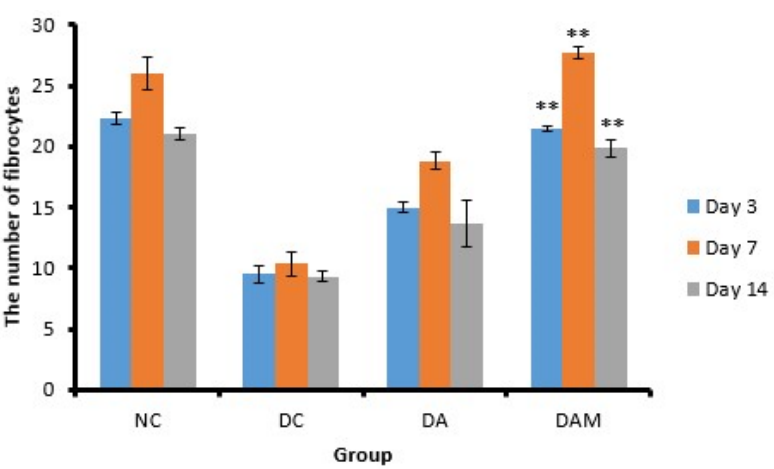
Figure 8. Number of fibrocytes at the three variation times. Notation on the graph shows the result of the statistical test ( α < 0.05).** notation shows insignificant differences with NC but significant differences with DC. ** = α ≤ 0.01. NC: normal group; DA: alginate treatment group; DAM: alginate– mangosteen rind extract treatment group; and DC: diabetic